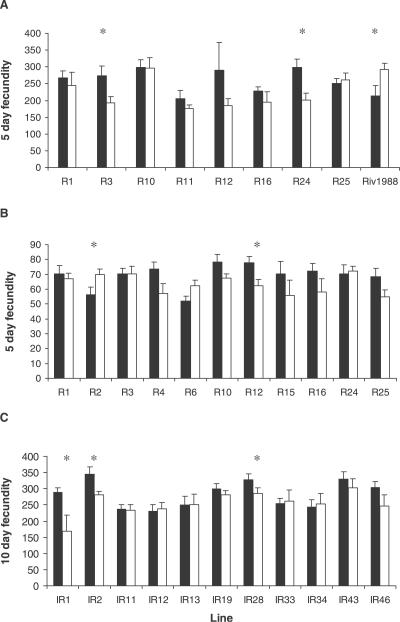
Fecundity Assays on Infected and Uninfected Isofemale Lines of D. simulans Collected from California in 2002 and 2004(A) Mean number of eggs over 5 d laid by infected (black bars) and uninfected (white bars) lines collected at Riverside in 2002 and 1988. The 2002 lines were assayed four generations after collection. A significant overall increase in fecundity was associated with the infection (F
1,108 = 6.7, p = 0.011).(B) Mean number of eggs over 5 d laid by infected (black) and uninfected (white) lines collected at Riverside in 2002 and assayed 10 mo after collection. These flies were cultured on a yeast-restricted diet. Again, the infection produced a significant overall increase in fecundity (F
1,213 = 5.8, p = 0.017).(C) Mean number of eggs over 10 d laid by infected (black) and uninfected (white) lines collected at Irvine in 2004 and assayed five generations after collection. Infection status had a significant effect on fecundity (F
1,185 = 8.03, p = 0.005).Error bars are standard errors, and asterisks indicate significant differences at the 5% level.